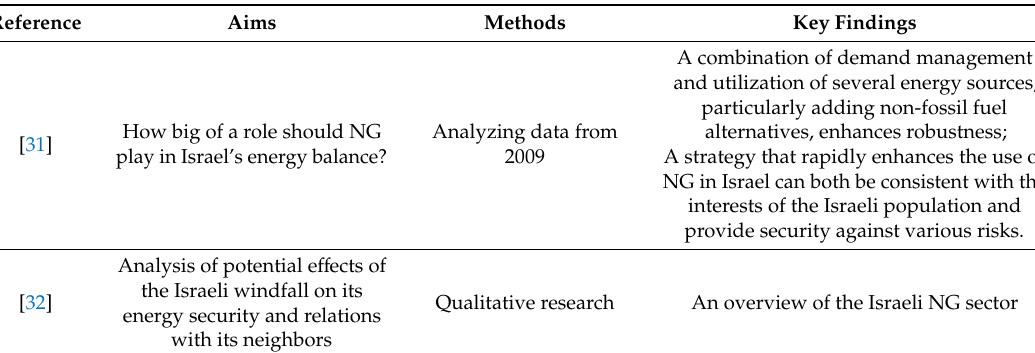
Table 1. Recent studies covering the Israeli natural gas (NG)